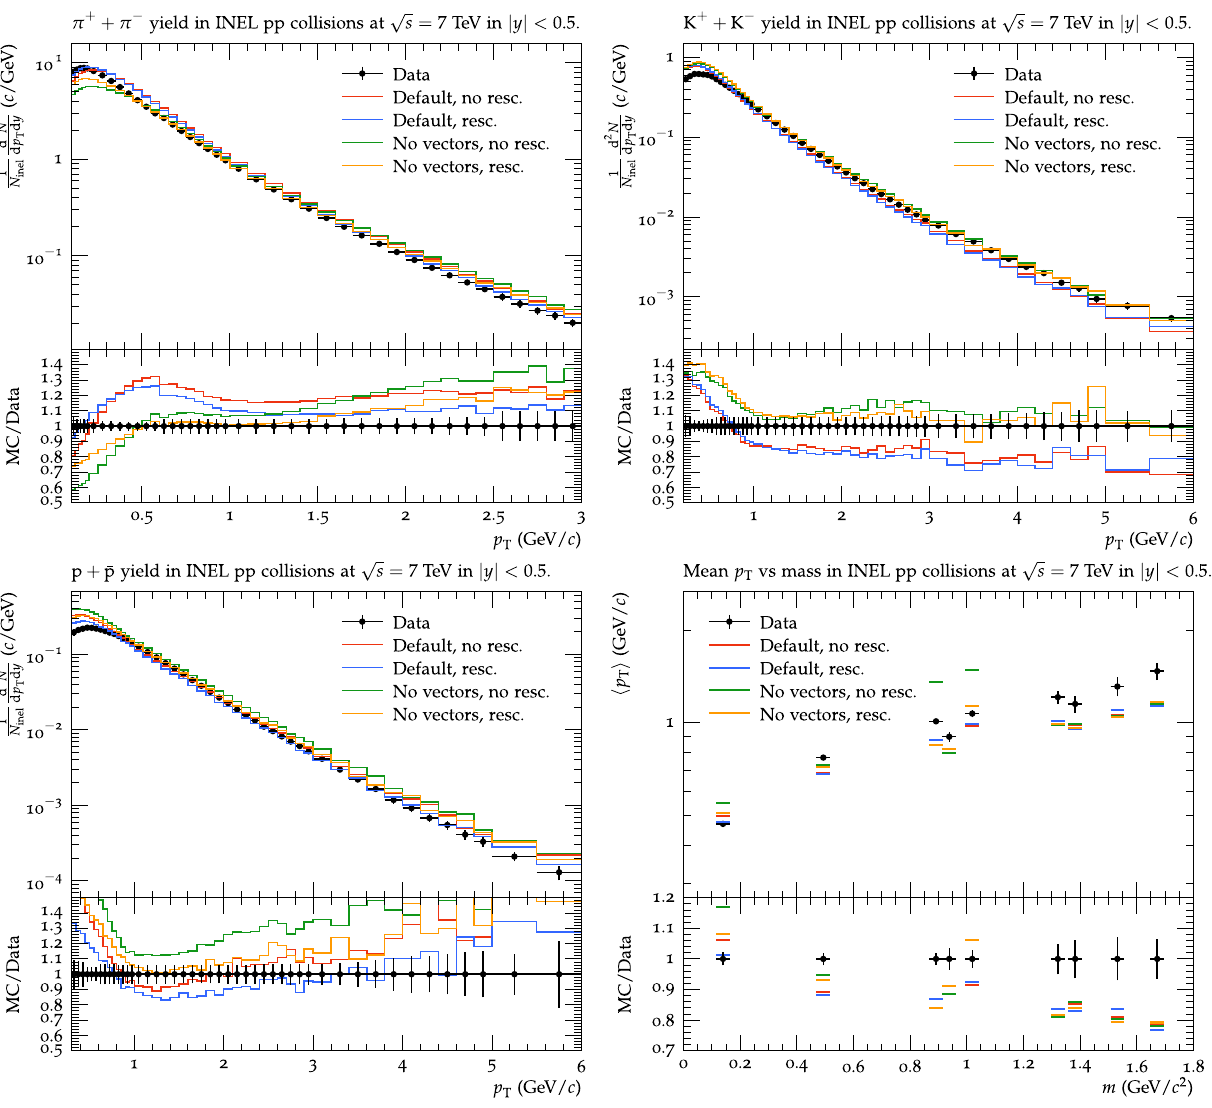
Fig. 23 p ⊥ spectra for π ± , K ± and p / p and average p ⊥ for various particles, comparing rescattering to no rescattering, when no vector